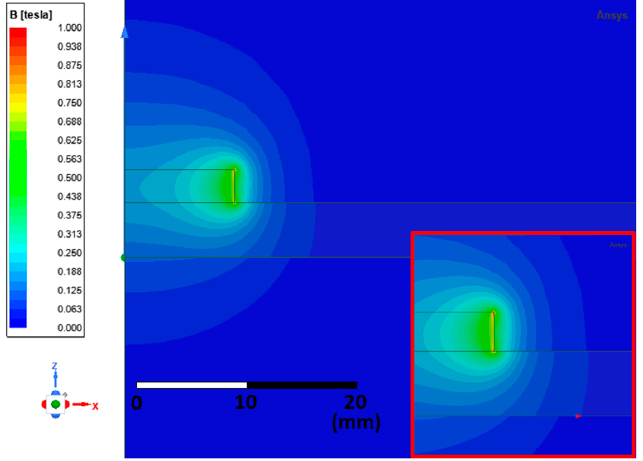
Figure 11. The calculated magnetic field distribution—Magnetic induction B (T). The view in detail is shown in the inset.